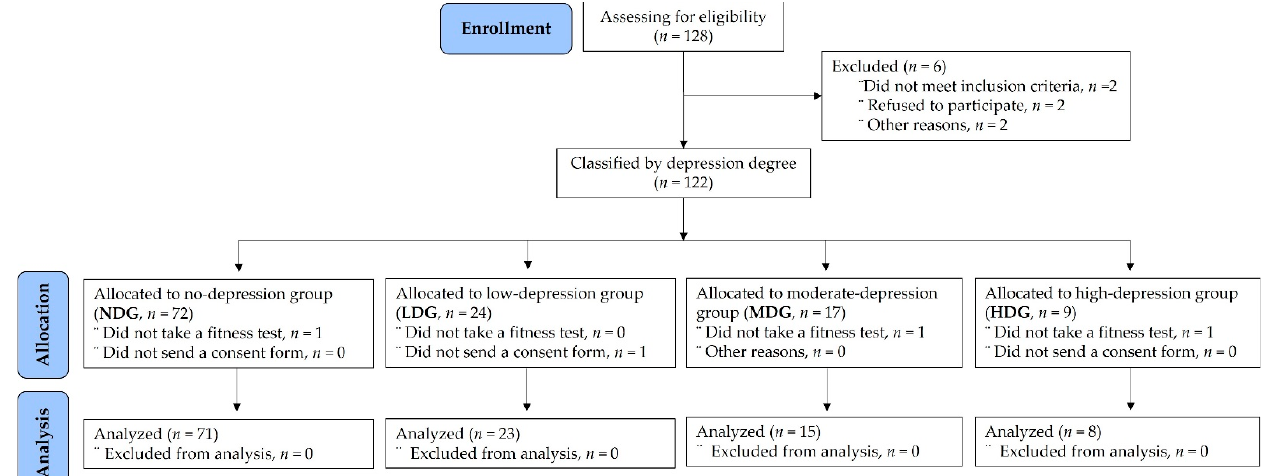
Figure 1. Participants’ allocation and analysis.